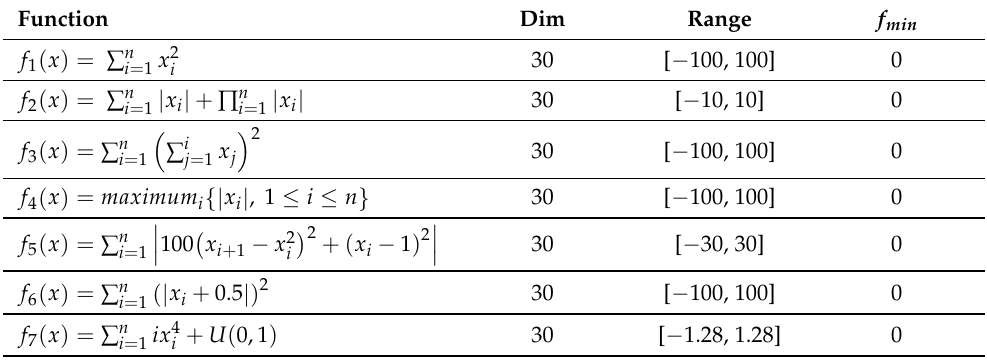
Table 2. Benchmark Function. Function